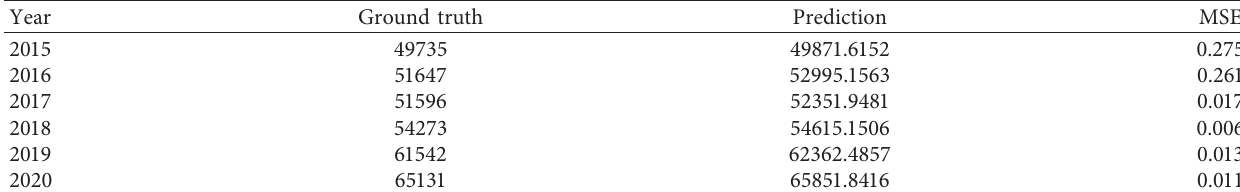
Table 2: Prediction results and errors of our composite model.